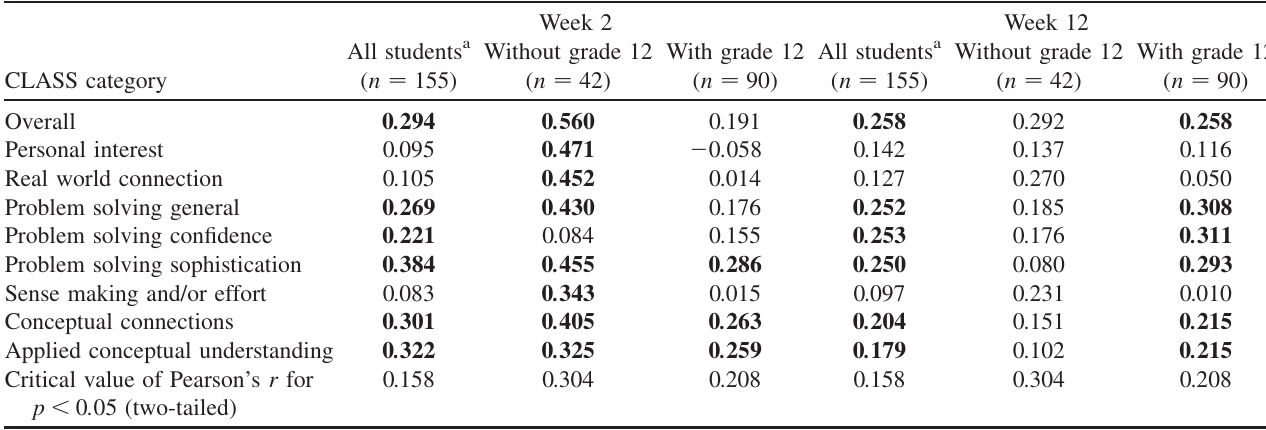
TABLE IV. Correlations (Pearson’s r ) between favorable attitudes about physics and FCI score for students with and without grade 12 physics in week 2 and week 12. Statistically significant results at the p < 0 : 05 level are shown in